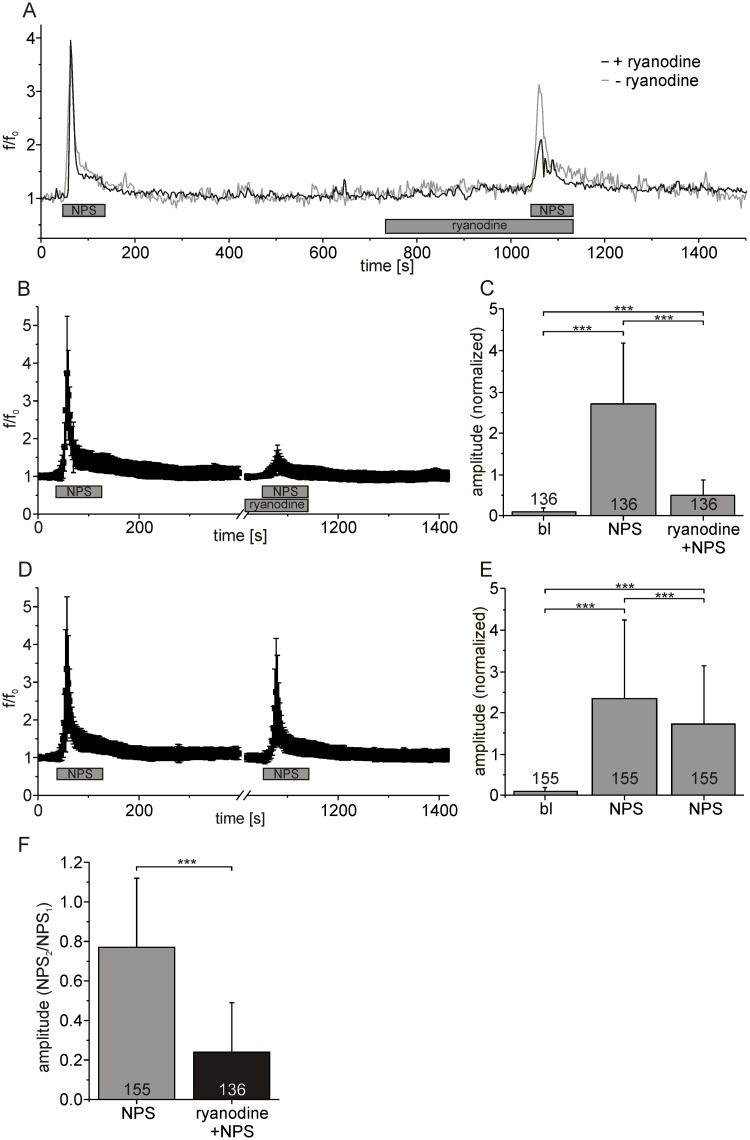
NPSR1-mediated IP3 receptor activation triggers calcium-induced calcium release via ryanodine receptors.(A) Fluorescence recording from a single neuron treated with ryanodine [50 μM] (black) and an untreated control (grey). (B) Mean fluorescence intensities calculated from 136 individual neurons. (C) Mean amplitudes calculated from the dataset shown in (B). (D) Fluorescence as averaged from 155 control neurons for two consecutive NPS applications in the absence of ryanodine. (E) Mean amplitudes calculated from the dataset shown in (D). (F) Mean amplitudes for the second application of NPS normalized to the preceding first NPS-administration in control cells (grey) and in the presence of ryanodine (black). NPS was used at 500 nM in all experiments.